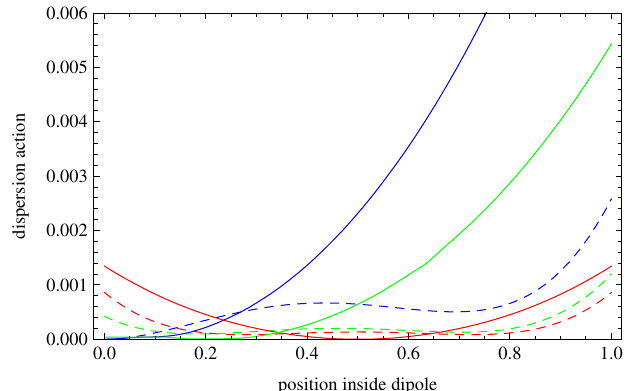
FIG. 6. Dispersion action inside the optimal dipoles shown in Figs. 4 and 5 for AME (blue), TME (red), and EME (green). Dashed curves are corresponding dispersion actions in the ref- erence uniform dipole.